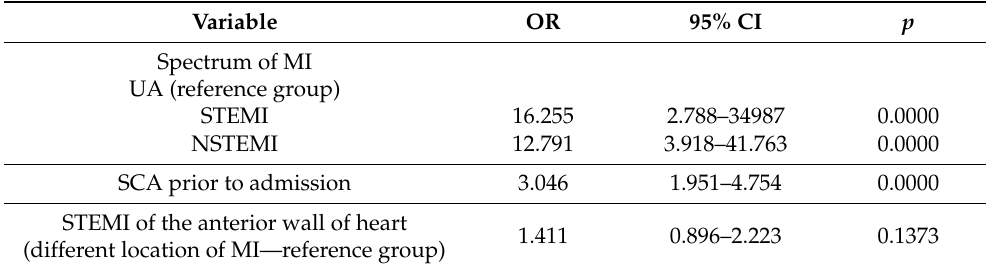
Table 3. Analysis of the univariate logistic regression model’s influence on specific variables of the patients’ risk of in-hospital